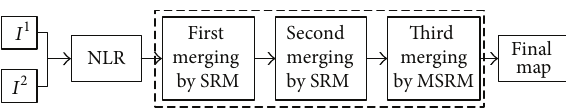
Figure 1: General scheme of the proposed